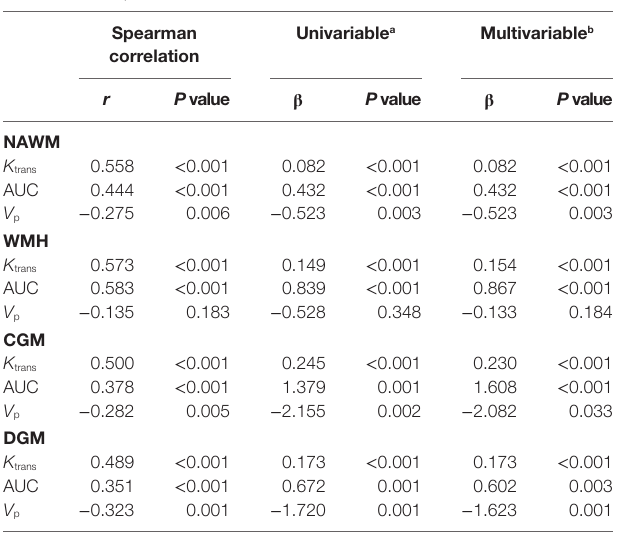
TaBle 3 | Association of leakage rate, area under the leakage curve, and fractional blood plasma volume with total MRI cSVD burden. spearman Univariable correlation